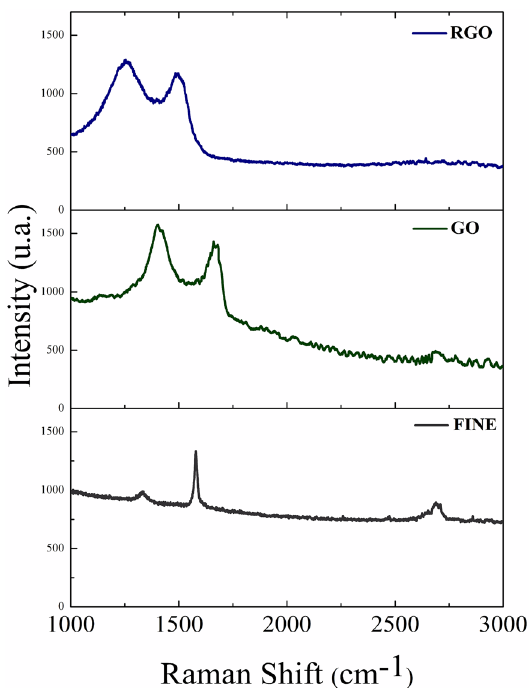
Figure 3. Raman spectra of FINE, GO and